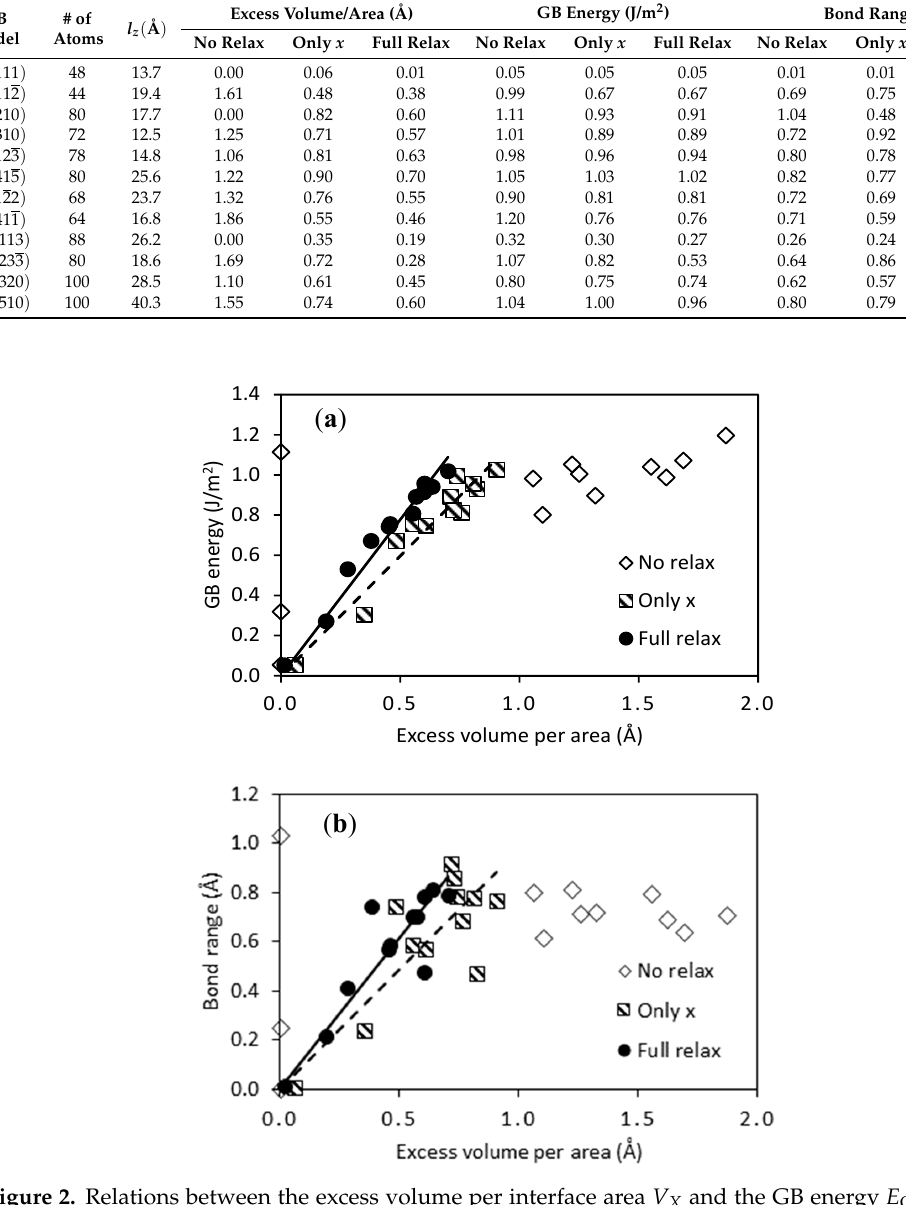
Figure 2. Relations between the excess volume per interface area V X and the GB energy E GB ( a ) or the bond range ∆ r b ( b ) for the interface models listed in Table 1. The three VRTs are marked by open diamonds (no relaxation of the unit cell size), striped squares (only relaxation of the x axis), and filled circles (full relaxation of all degrees of freedom). Linear fits to the two latter techniques are shown as dashed and solid lines.